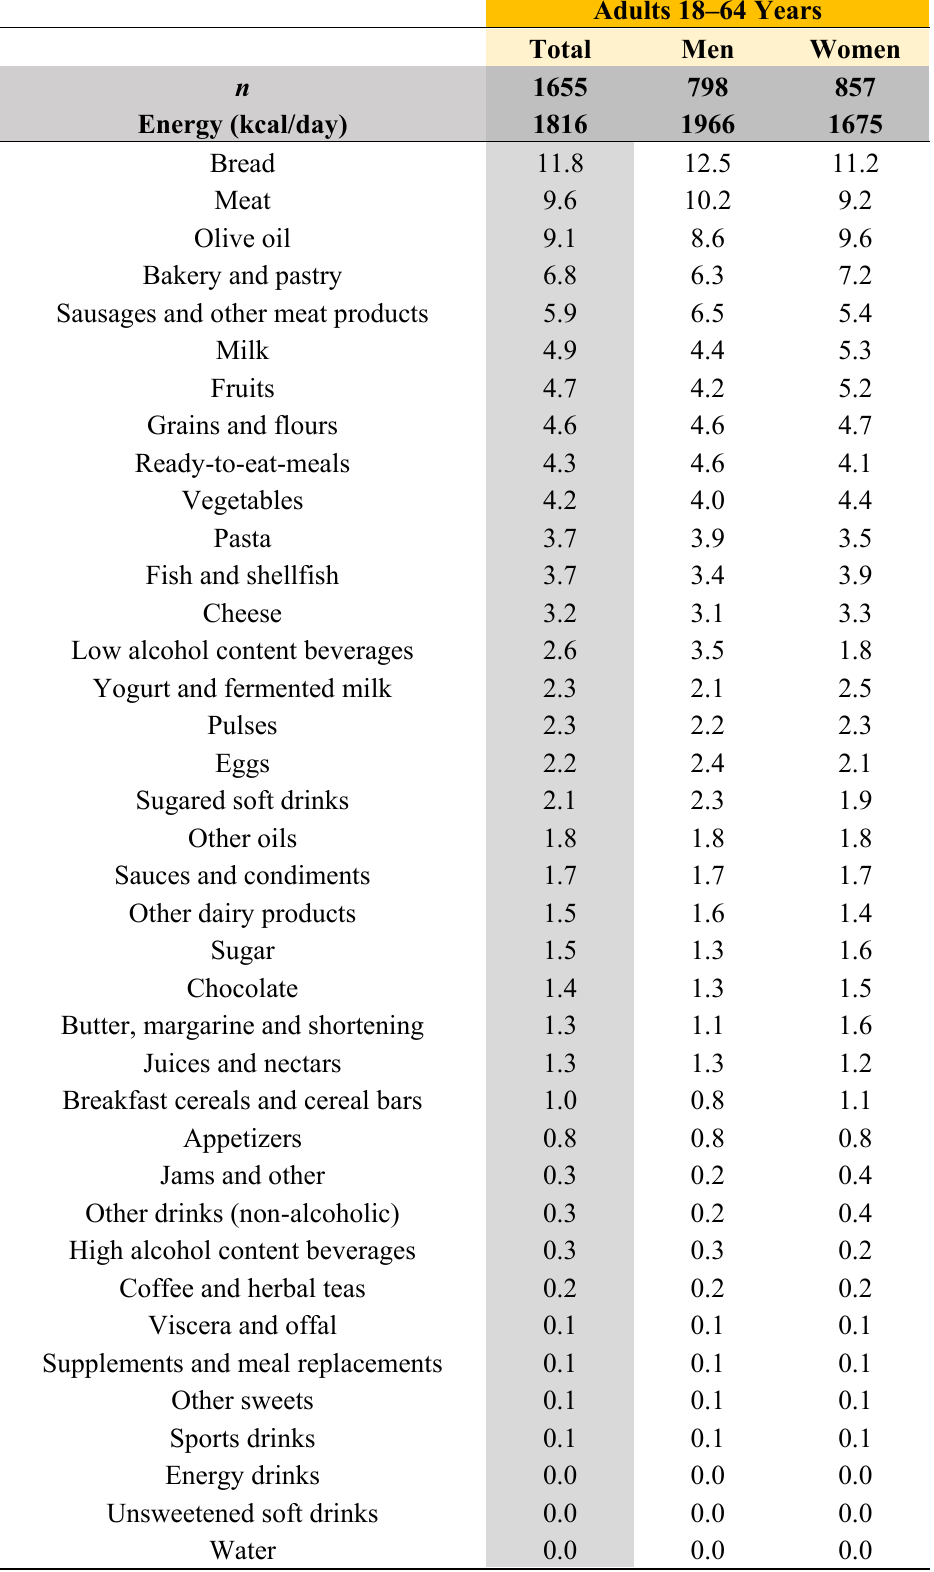
Table 8. Dietary sources of energy (%) from food subgroups in adults from the ANIBES survey of the Spanish